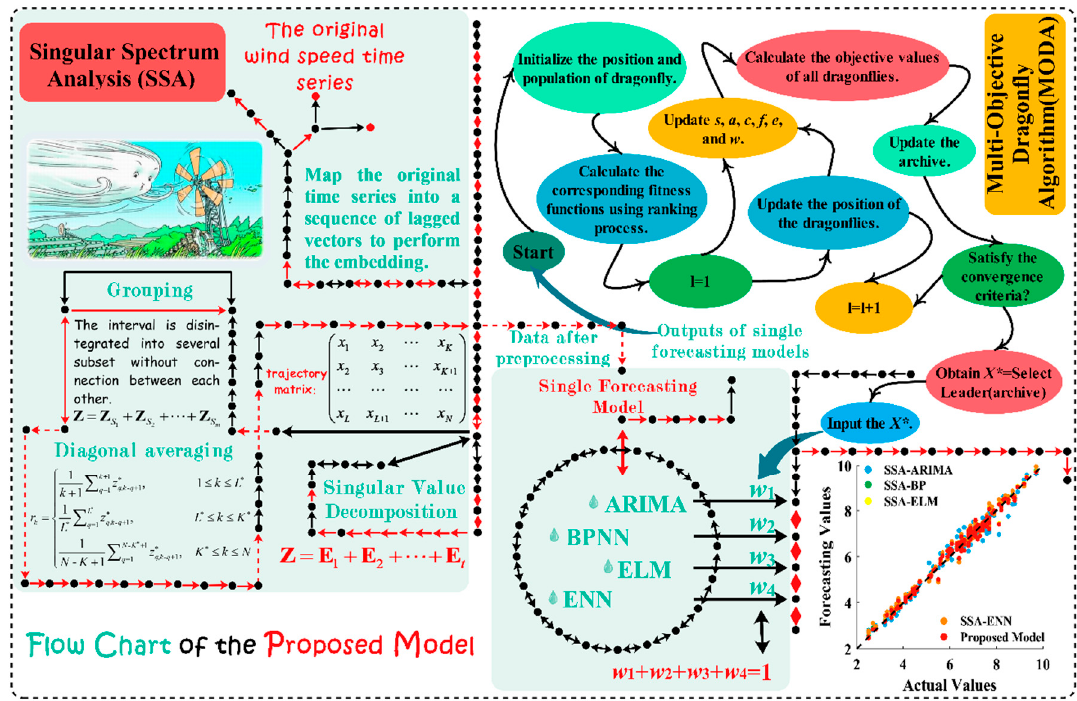
Figure 1. Flow chart of the developed model.